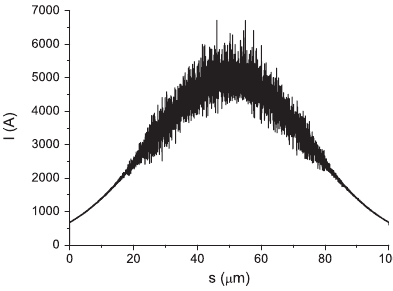
FIG. 4. Modulation of current in the beam passed SASE1 undulator [12] and a dispersion section with R 56 equal to 50 (cid:4) m .